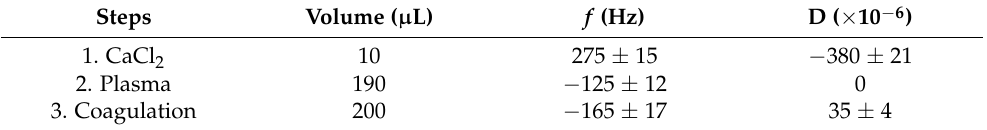
Table 2. Resonance frequency ( f ) and dissipation (D) of the fifth overtone due to changes in the adsorption on the Ca surface. Step 1 corresponds to the passage from air to CaCl 2 (liquid). Step 2 corresponds to the addition of plasma (liquid) to the CaCl 2 (liquid). Step 3 corresponds to coagulation. Steps